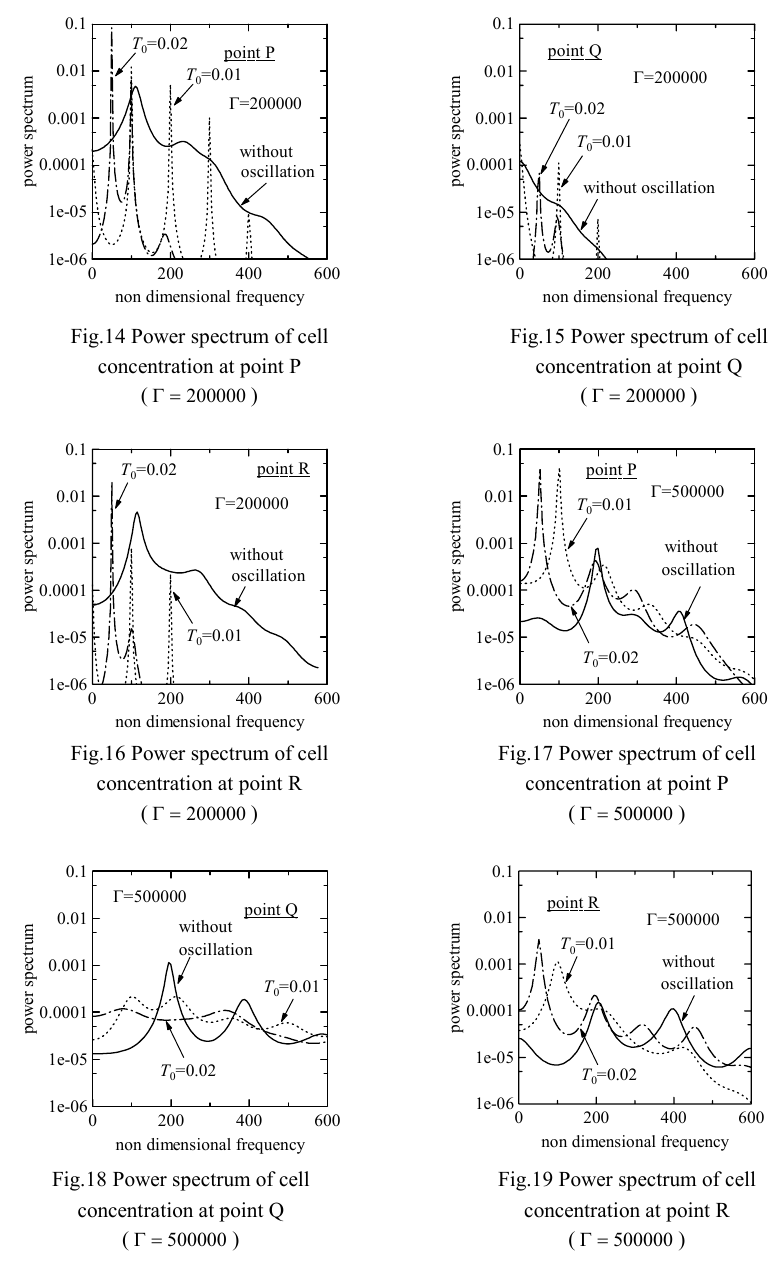
Fig.19 Power spectrum of cell concentration at point R